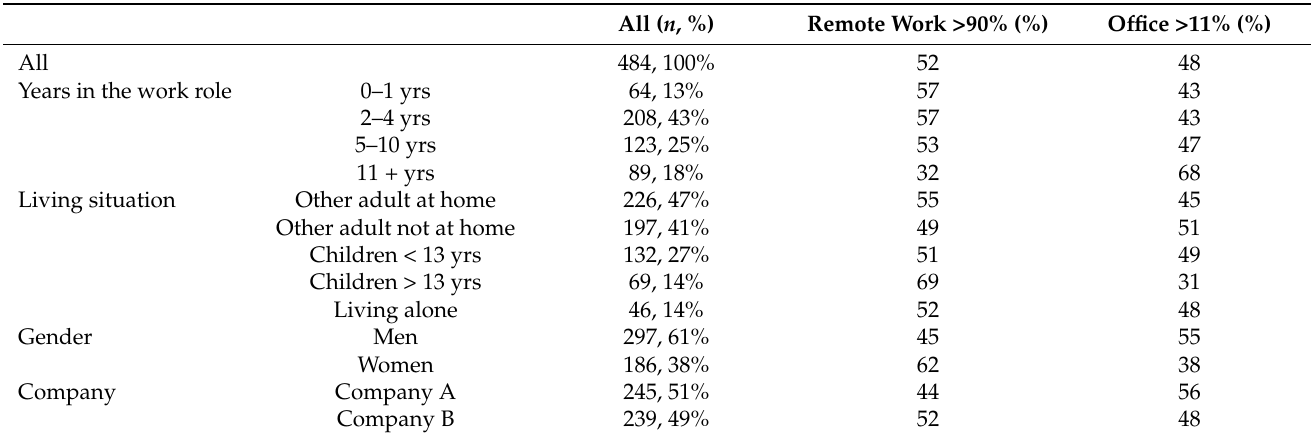
Table 1. Characteristics of the study group.